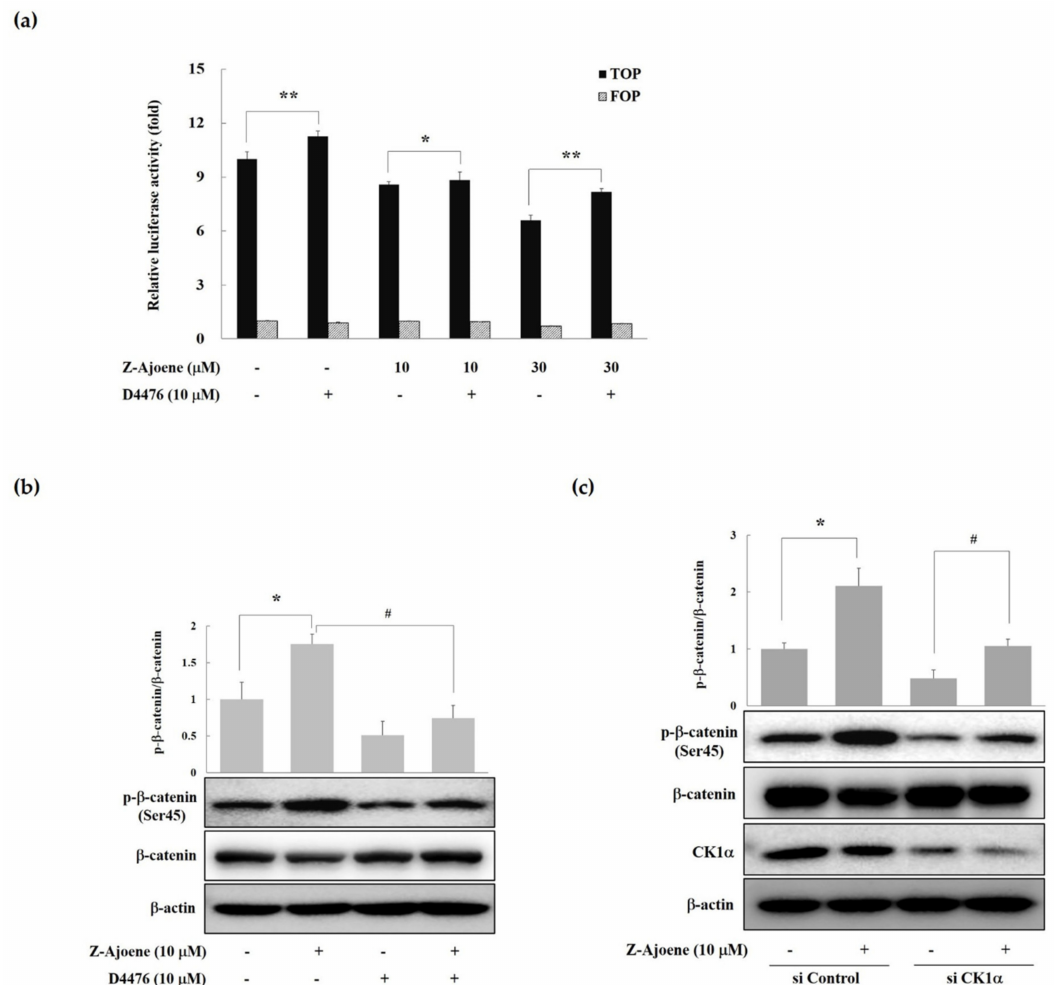
Figure 4. E ff ects of Z-ajoene and a CK inhibitor on phosphorylation at Ser45 of β -catenin in SW480 colon cancer cells. ( a ) SW480 colon cancer cells transfected with TOPFlash / FOPFlash were incubated with Z-ajoene and / or D4476 for 15 h. The luciferase activity was expressed as relative TOPFlash activity compared to vehicle-treated cells. The results represent the mean ± S.D. of three independent experiments. * p < 0.5 indicates a significant di ff erence compared to Z-ajoene (10 µ M) alone. ** p < 0.05 indicates a significant di ff erence compared to vehicle or Z-ajoene (30 µ M) alone; ( b ) the levels of phosphorylated β -catenin at Ser45 (p- β -catenin at Ser45) were evaluated by Western blotting. SW480 colon cancer cells were pre-treated with D4476 (a casein kinase I inhibitor, 10 µ M), and then incubated with Z-ajoene for 30 min. The ratio of p- β -catenin (Ser45) to β -catenin was expressed relative to the values in the vehicle-treated cells. *, # p < 0.05 indicates a significant di ff erence compared to vehicle (*) or a Z-ajoene (#) treated group. The images are representative of three independent experiments with similar results. ( c ) The levels of phosphorylated β -catenin at Ser45 (p- β -catenin at Ser45) were evaluated by Western blotting. SW480 colon cancer cells were transfected with control siRNA or CK1 α siRNA (50 pM) and then incubated with Z-ajoene for 30 min. The ratio of p- β -catenin (Ser45) to β -catenin was expressed relative to the values in vehicle-treated cells. *, # p < 0.05 indicates a significant di ff erence from vehicle treatment. The images are representative of three independent experiments with similar